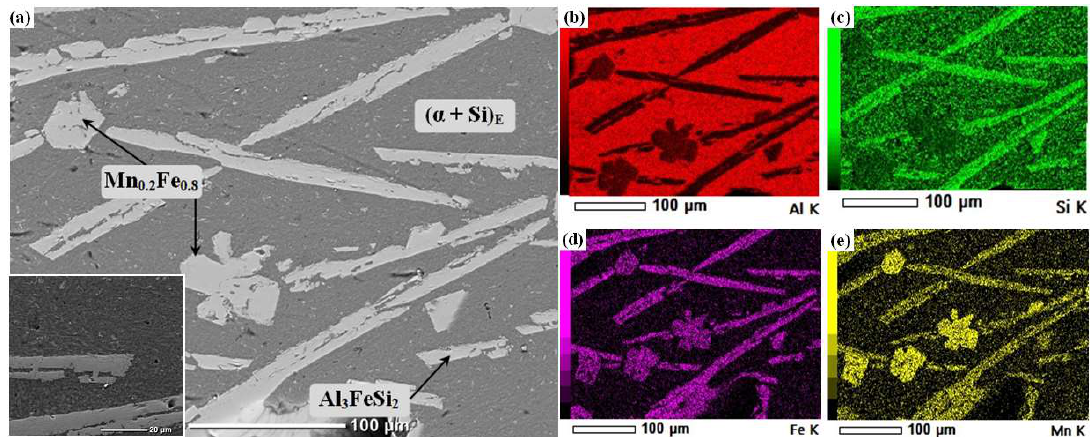
Figure 14. ( a ) Backscattered electron image of AlSiFe with 3 wt. % Mn alloy, eutectic microstructure as insert. Elemental mapping of ( b ) aluminum, ( c ) silicon, ( d ) iron, ( e ) manganese. (α+Si) E = Eutectic.